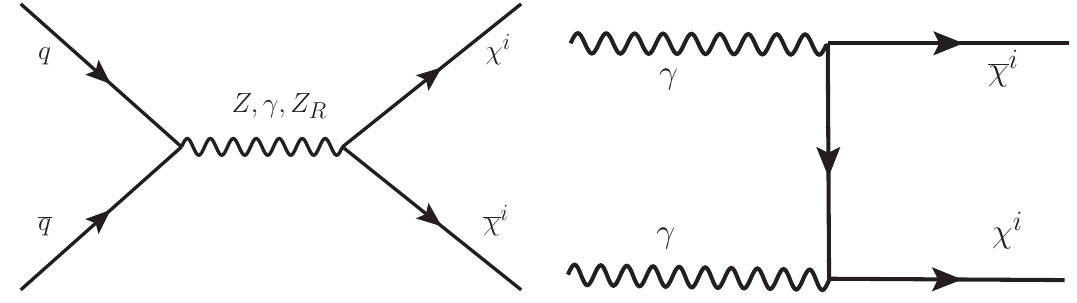
Figure 2 . The left panel shows the Feynman diagram for the s-channel Drell-Yan pair-production of the quintuplet fermion. The right panel portrays the Photo production of (cid:31) i (cid:31) i through t-channel photon-photon fusion